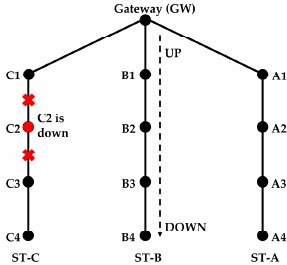
Figure 9. A node is down at the time of routing initialization.